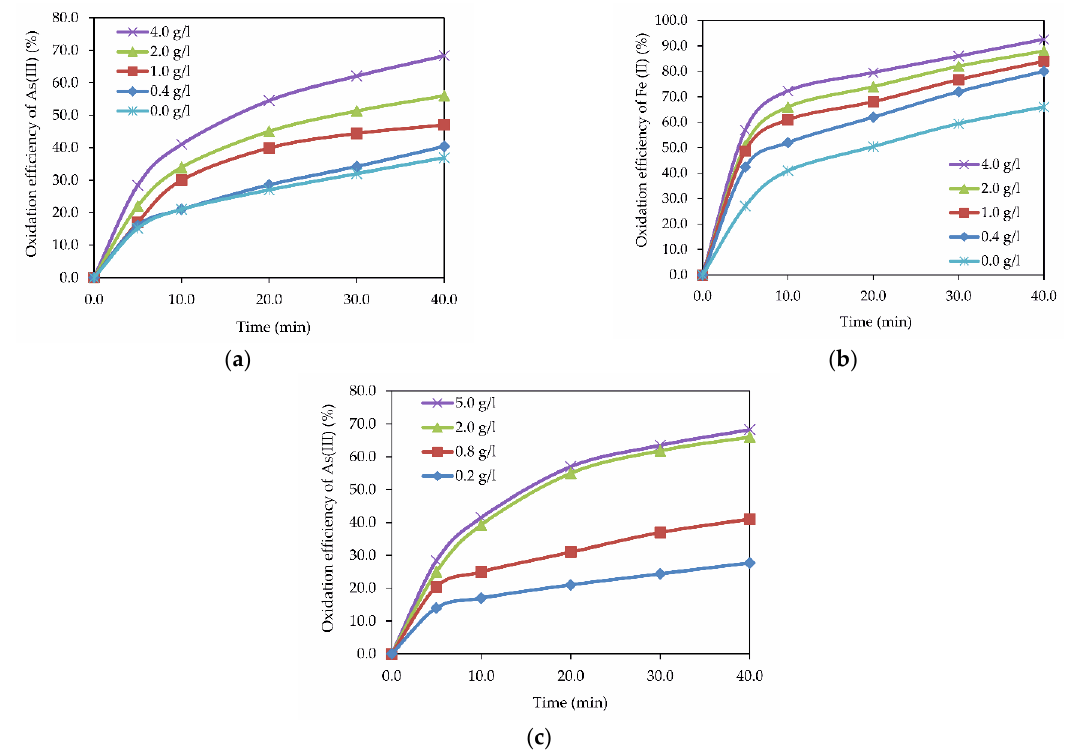
Figure 4. Oxidation efficiency of As (III) as a function of the copper concentration in the presence of iron ( a ), iron in the presence of copper ( b ), the oxidation efficiency of As (III) as a function of Fe (II) concentration in the presence of the copper ( c ).